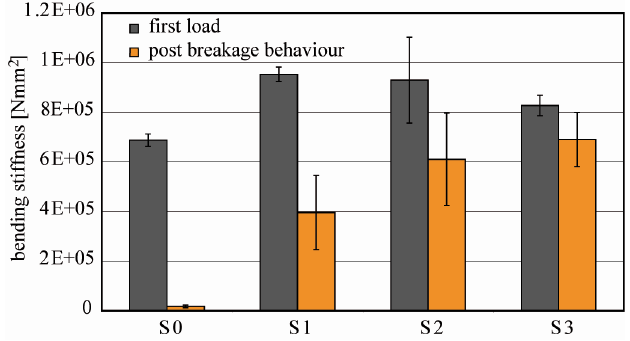
Figure 6: Bending stiffness of the tested